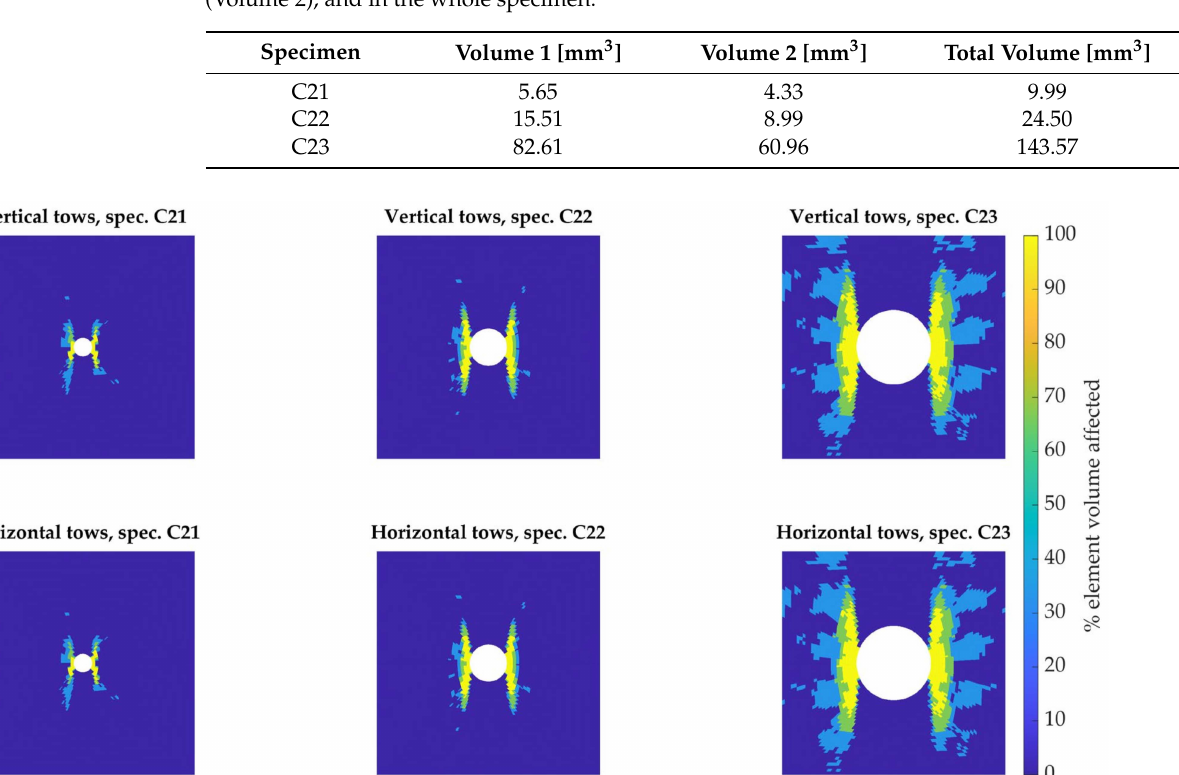
Table 5. Volumes affected by the stress concentration in vertical tows (Volume 1), in horizontal tows (Volume 2), and in the whole specimen.